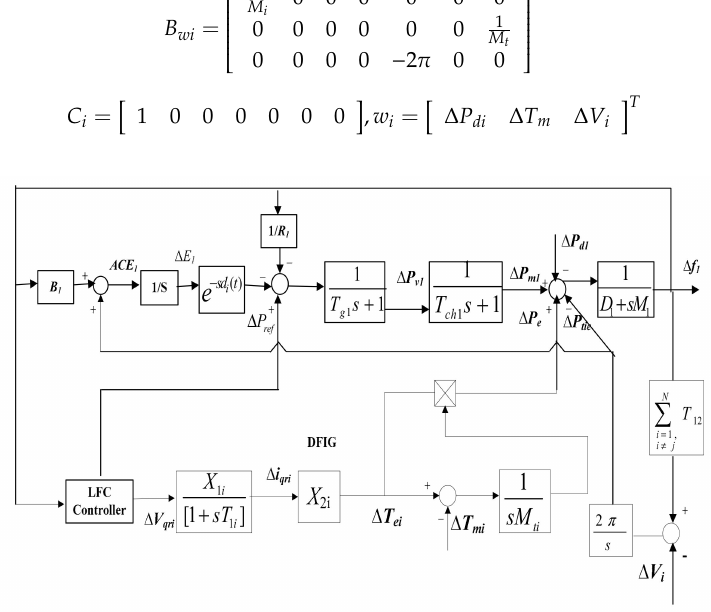
Figure 3. Dynamic model of one area of the interconnected environment.